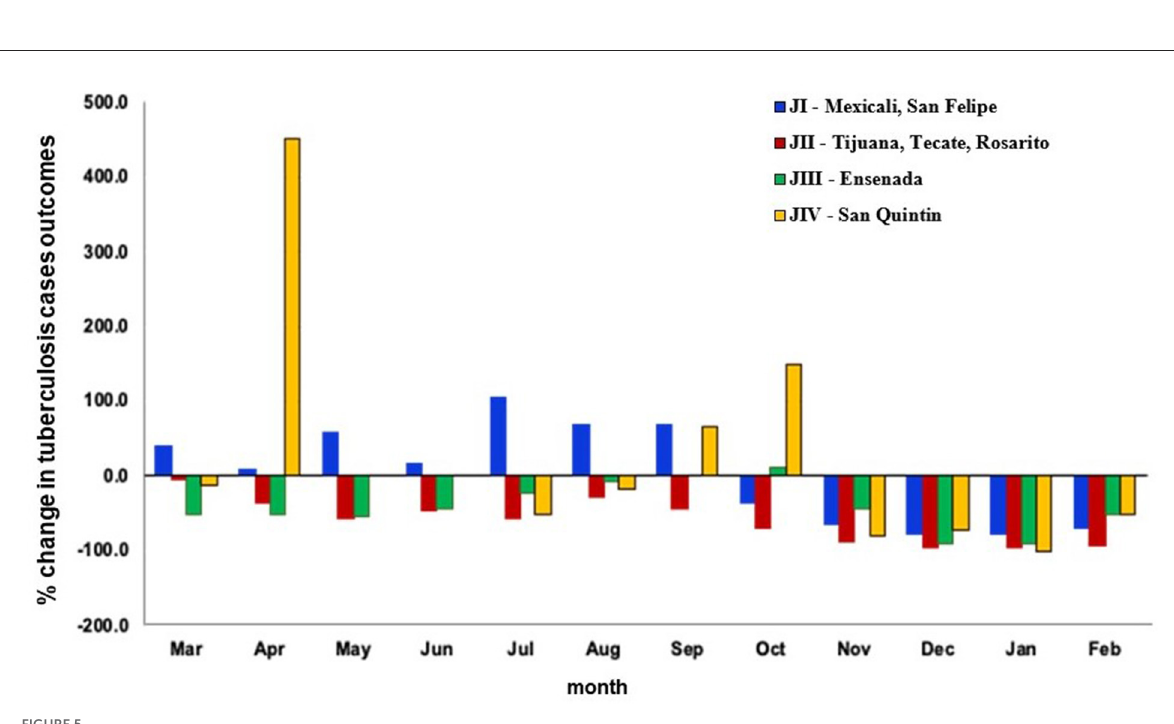
FIGURE5 Change in the proportion of tuberculosis treatment outcomes between the year before and first year during the COVID-19 pandemic by month and health jurisdiction, Baja California, México, 2019–2021. Data source: Mexico Ministry of Health management information system (https://